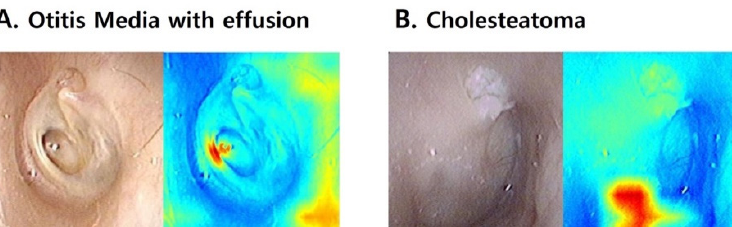
Figure 3. The regions of interest for tympanic membrane diagnosis were visualized as a heat map using Gradient-weighted Class Activation Mapping (Grad-CAM). ( A ) Grad-CAM focused on the pars tensa region of the normal tympanic mem- brane. ( B ) The change in color of the tympanic membrane due to middle ear effusion is important for the diagnosis of otitis media with effusion in the Grad-CAM analysis. ( C ) Chronic otitis media could be distinguished by perforation and remnant tympanic membrane. ( D ) In cholesteatoma, the location of the bony erosion was spotted in Grad-CAM.